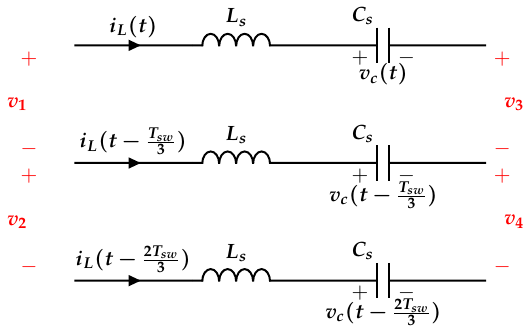
Figure 3. Equivalent circuit used for